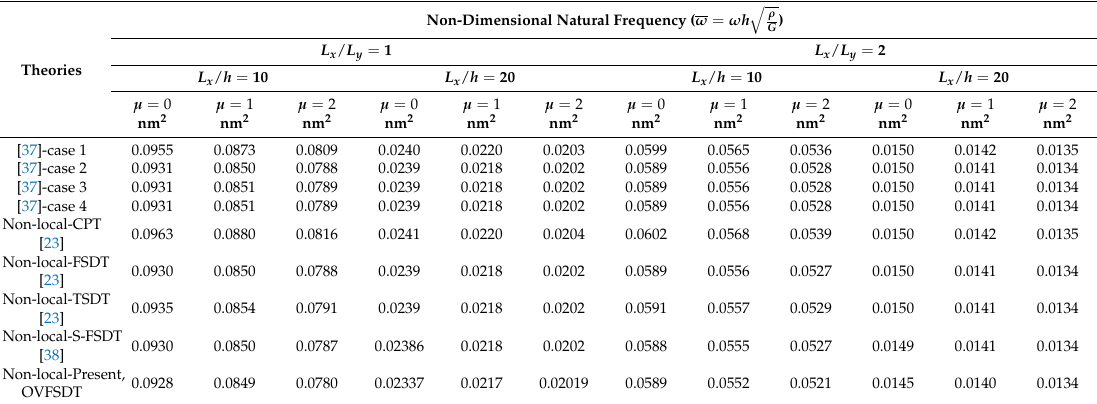
Table 3. Comparative evaluation between OVFSDT and other non-local plate models from literature. E = 1.02 TPa, υ = 0.3, h = 0.34 nm.